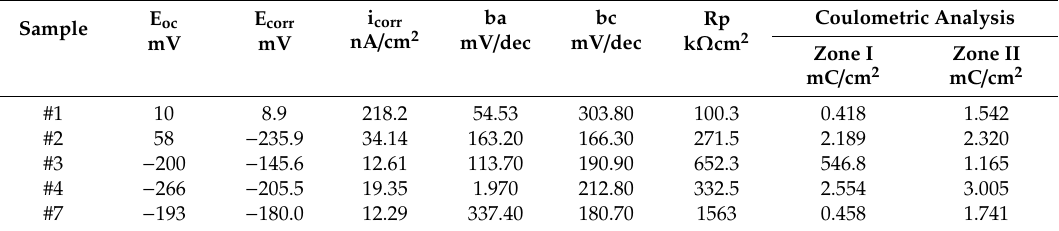
Table 6. Electrochemical parameters determined for Ti-based alloys in artificial plasma